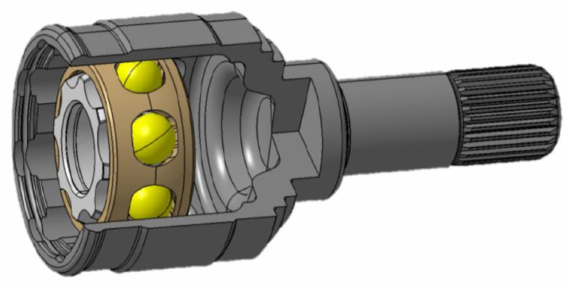
Figure 10. Axonometric cross-section of the bowl-balls-inner race